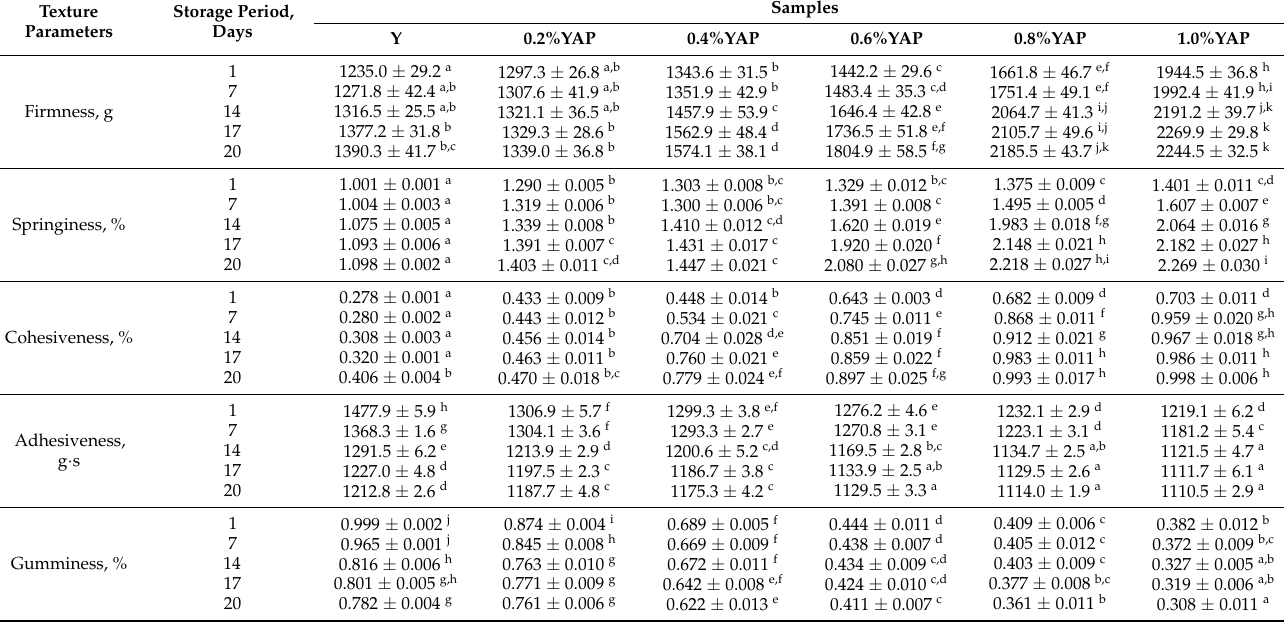
Table 7. Texture parameters’ evolution of yogurt with apple pomace powder during